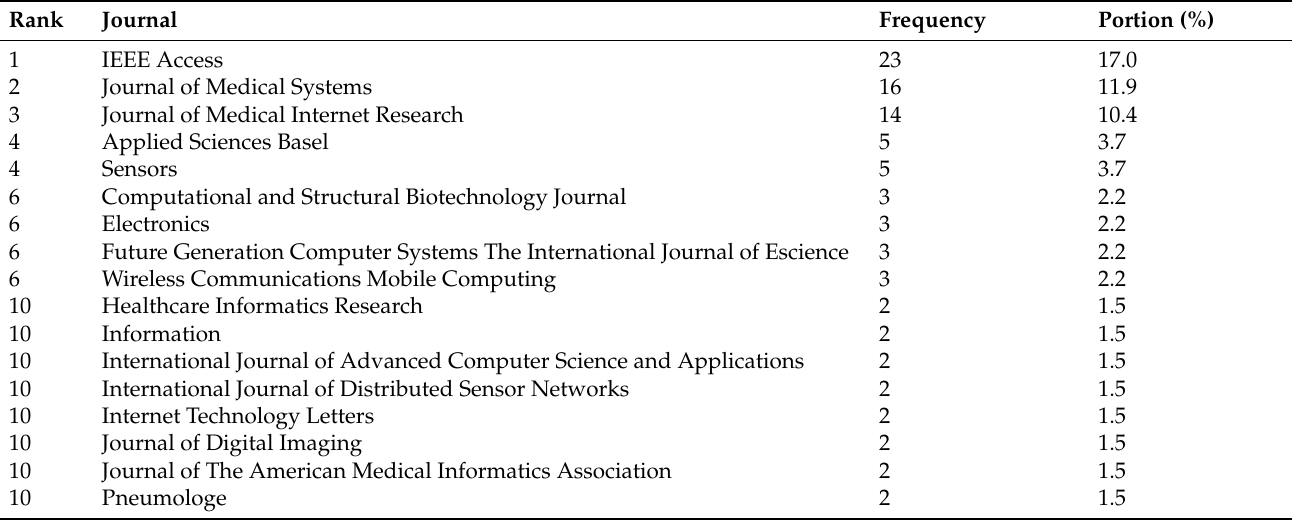
Table 2. Distribution of articles in